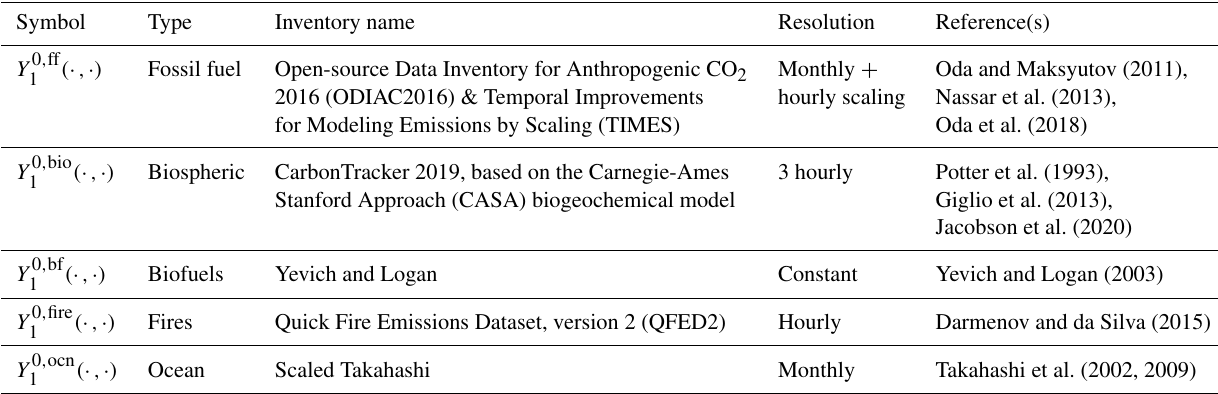
( s ,t) used in Eq. 1